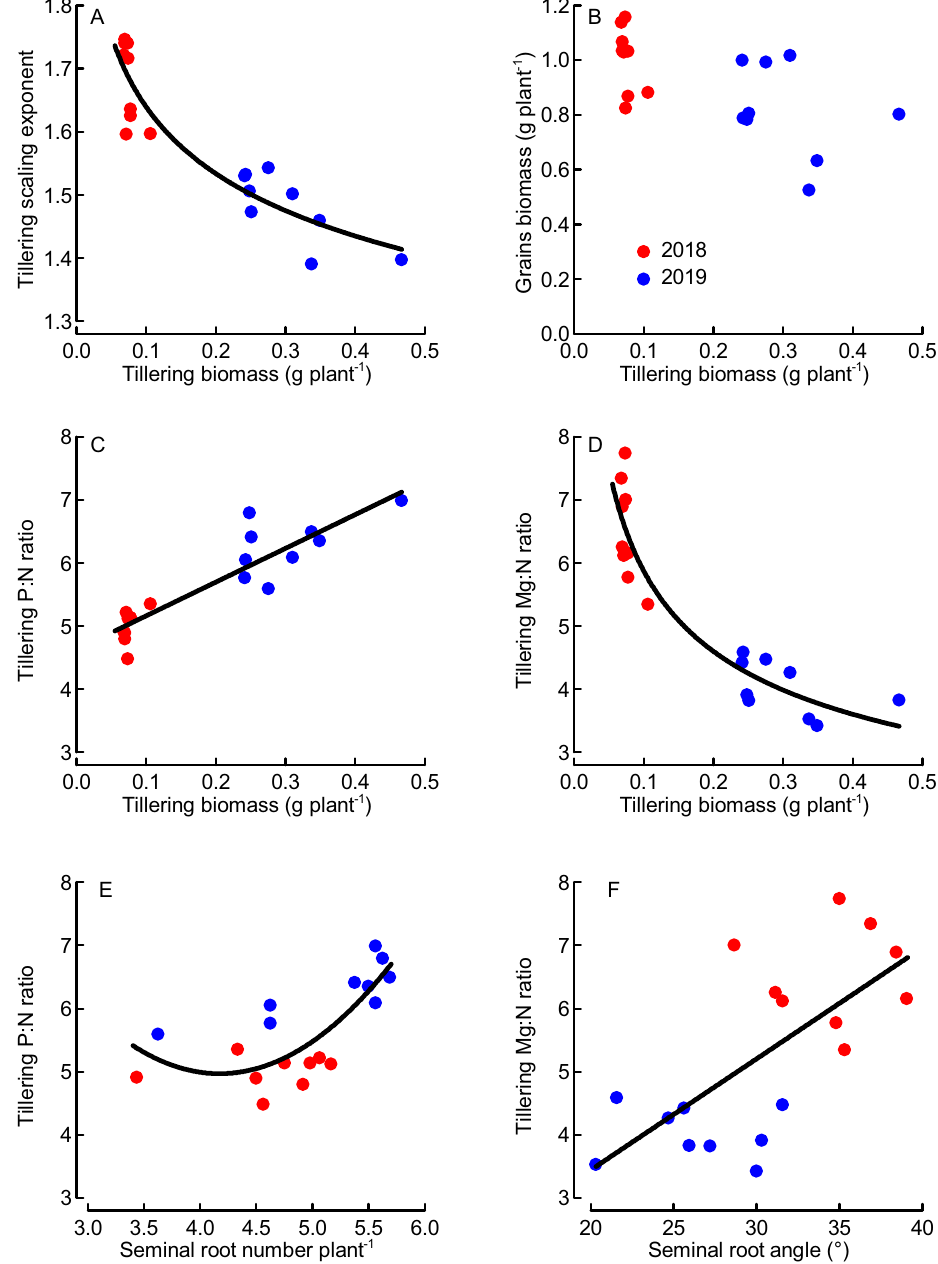
Figure 3. Scaling exponent (macroelements), nutrient ratios and harvested grains biomass as functions of early vigor biomass and root traits (tillering, BBCH29) 35 across nine wheat varieties field-grown in Sweden during two years (2018, 2019). Regressions: y = 1.314x −0.096 , N = 18, R 2 = 0.86, P < 0.001 ( A ); y = 5.340x + 4.630, N = 18, R 2 = 0.82, P < 0.001 ( C ); y = 2.611x −0.352 , N = 18, R 2 = 0.89, P < 0.001 ( D ); y = 0.744x 2 − 6.210x + 17.927, N = 18, R 2 = 0.61, P = 0.001 ( E ); y = 0.176x − 0.078, N = 18, R 2 = 0.47, P = 0.002 ( F ). Dots represent means from 4